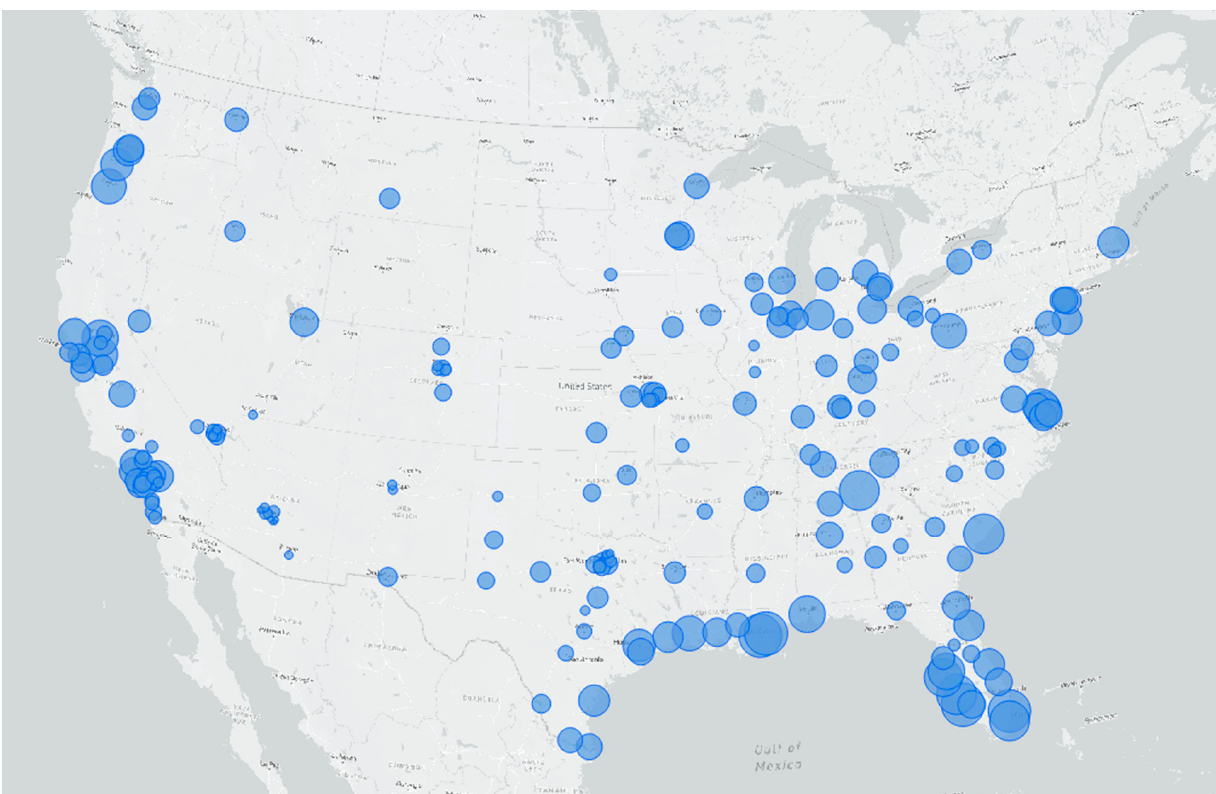
Figure 4. Overall risk by city (percent of infrastructure with operational risk). When examining the risk rankings by dimension (for a spatial visualization, see Figure 5), the highest percentage of critical infrastructure at risk among this list of